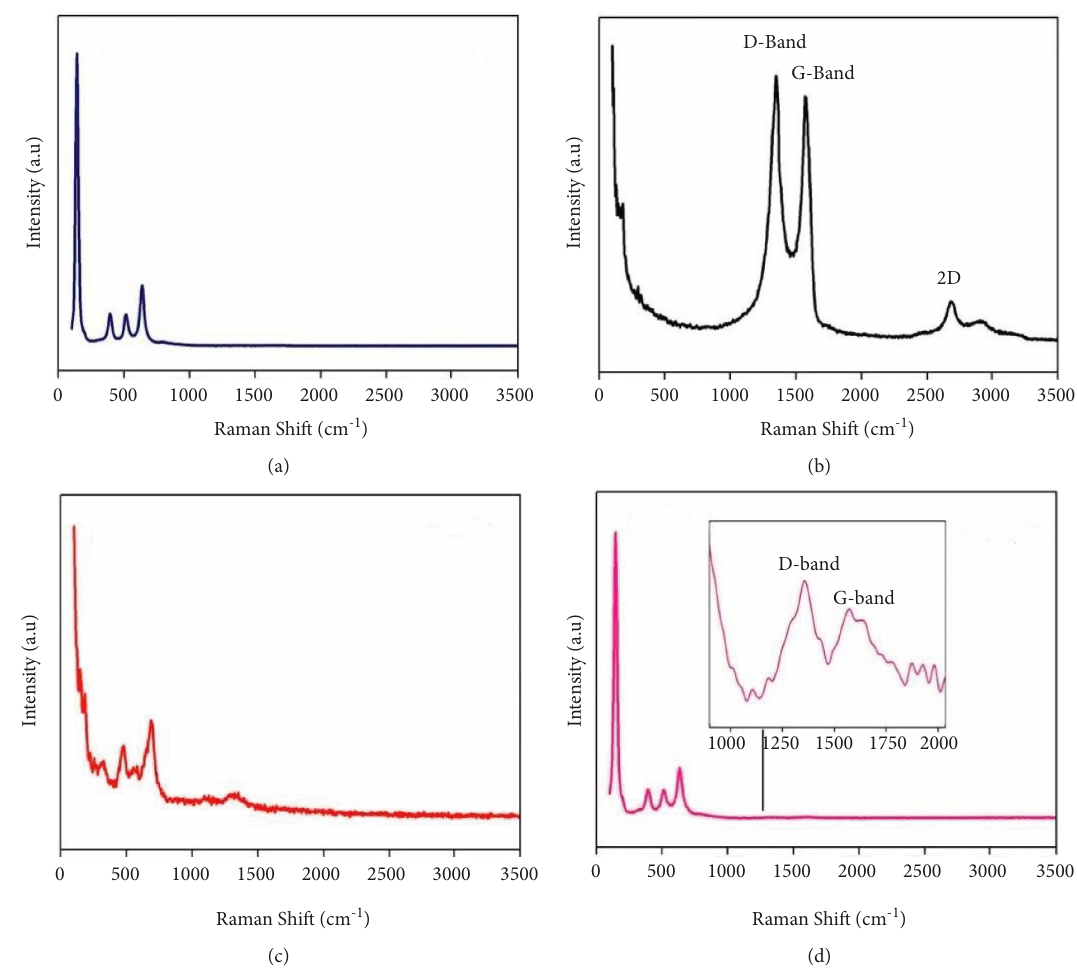
Figure 8: Raman spectra of (a) TiO 2 , (b) rGO, (c) NiFe2O4, and (d) NiFe2O4@TiO2@rGO core@shell nanoparticles.